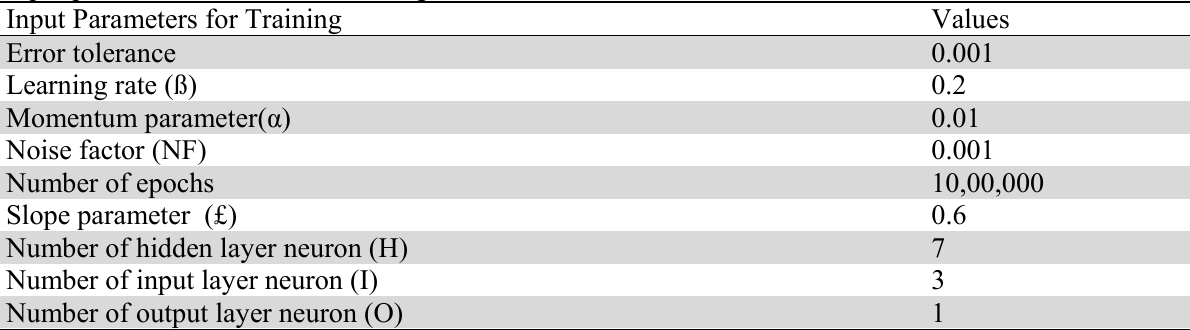
Input parameters selected for